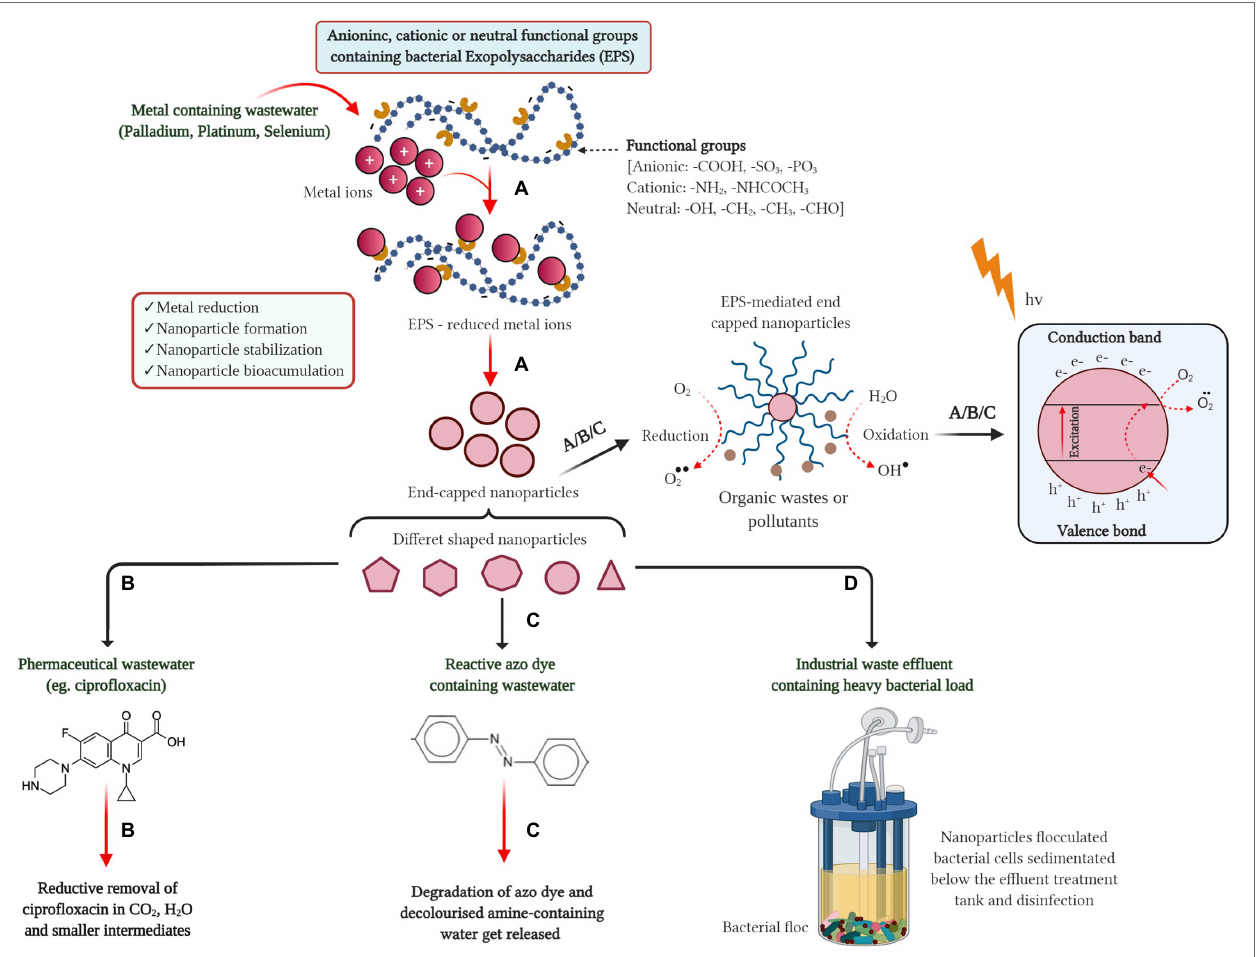
FIGURE 2 | Bacterial EPS in nanoparticle synthesis and its role in separation and adsorption of pollutants from wastewater. (A) Metal containing wastewater, (B) pharmaceutical wastewater, (C) textile wastewater, and (D) industrial wastewater with bacterial